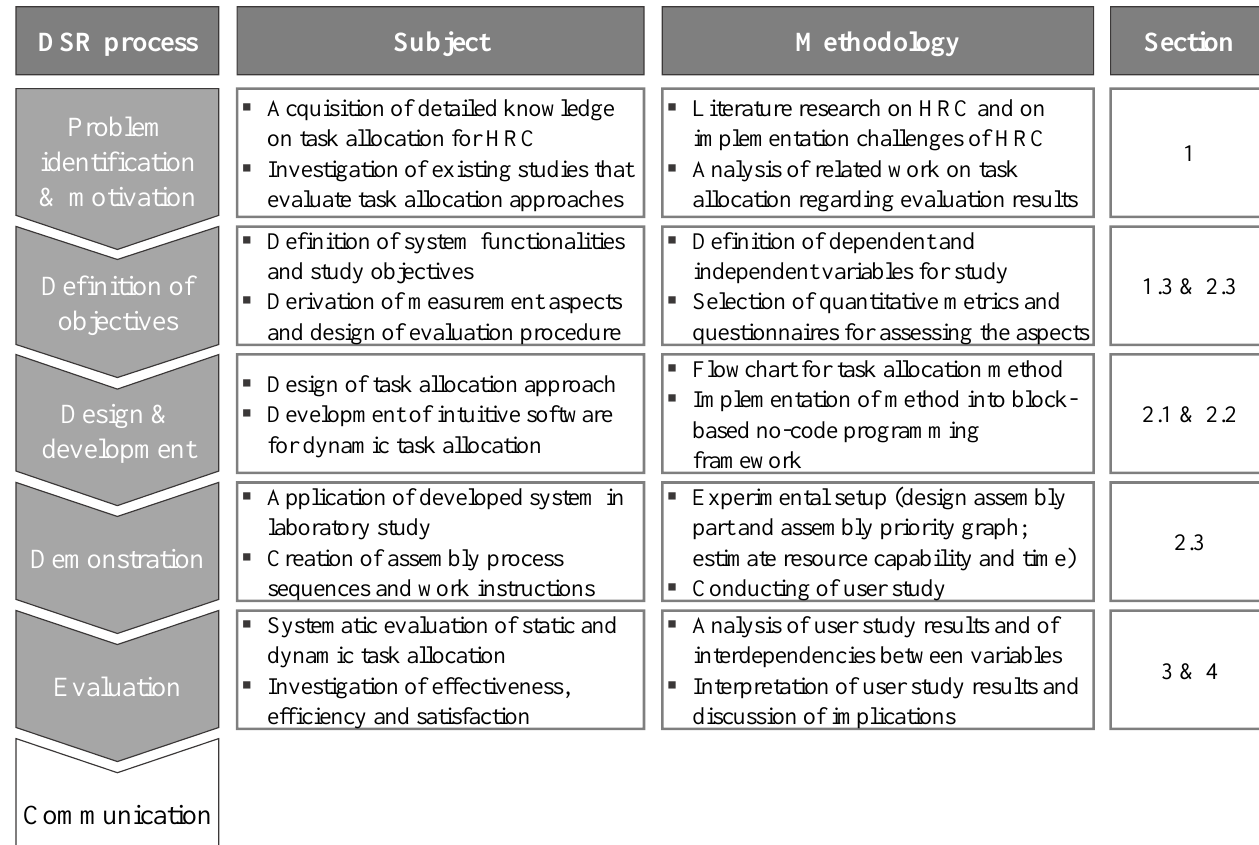
Figure 2. Research approach for the study following the Design Science Research procedure model from [46].